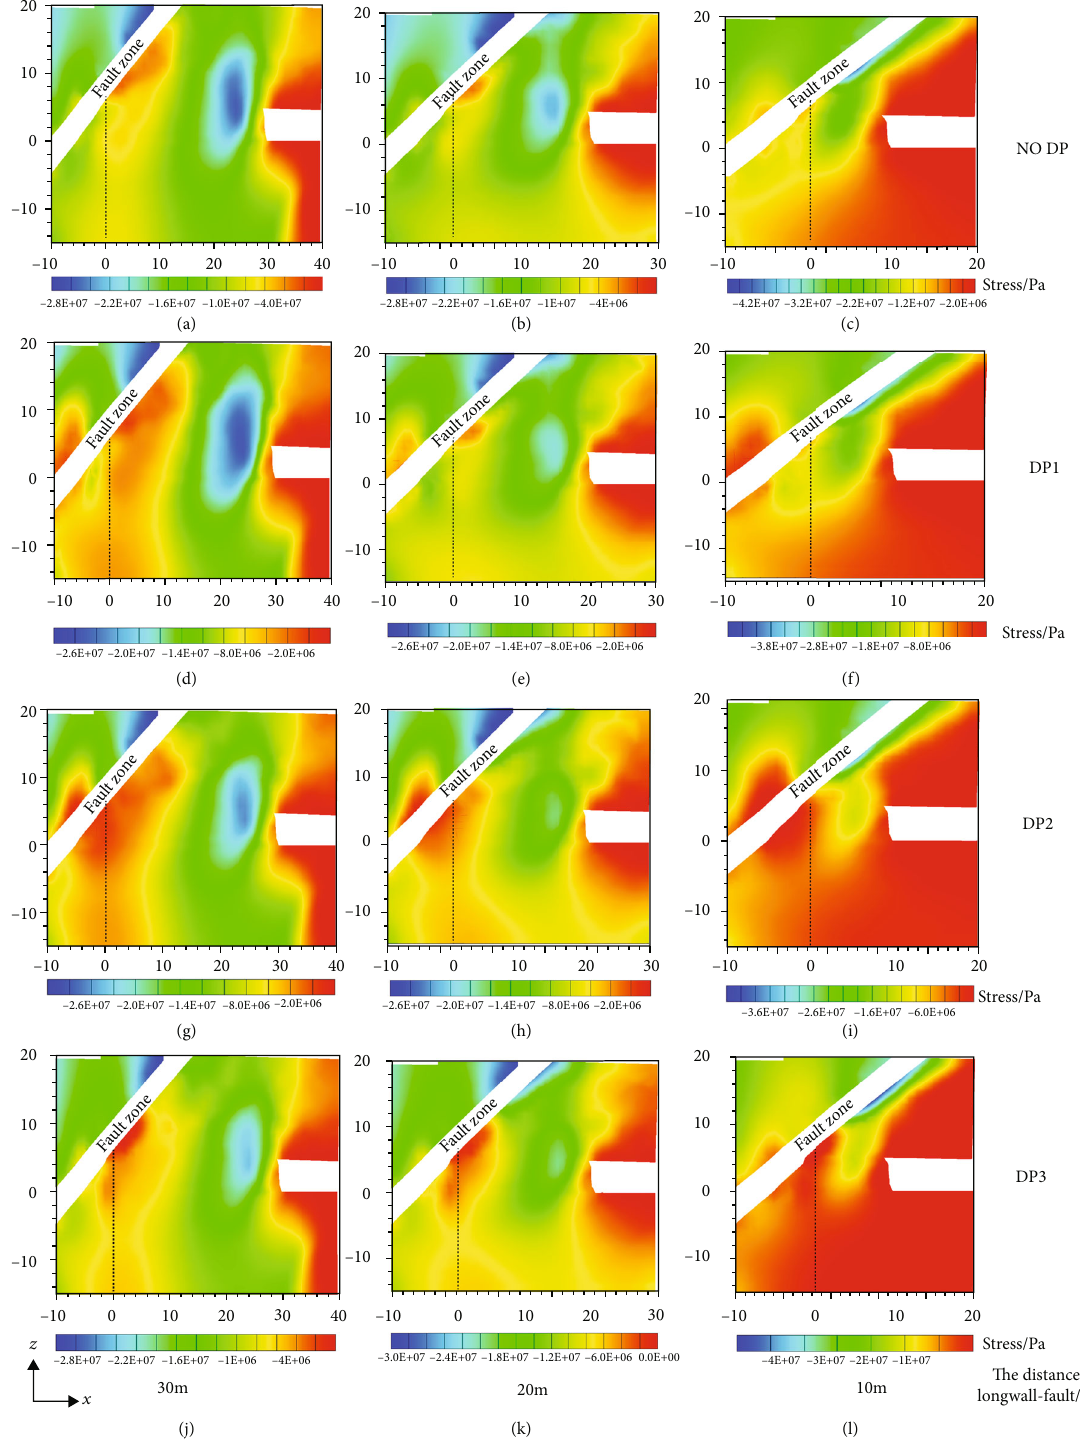
Figure 12: Vertical stress nephogram of the coal seam and the vicinity of faults under three external